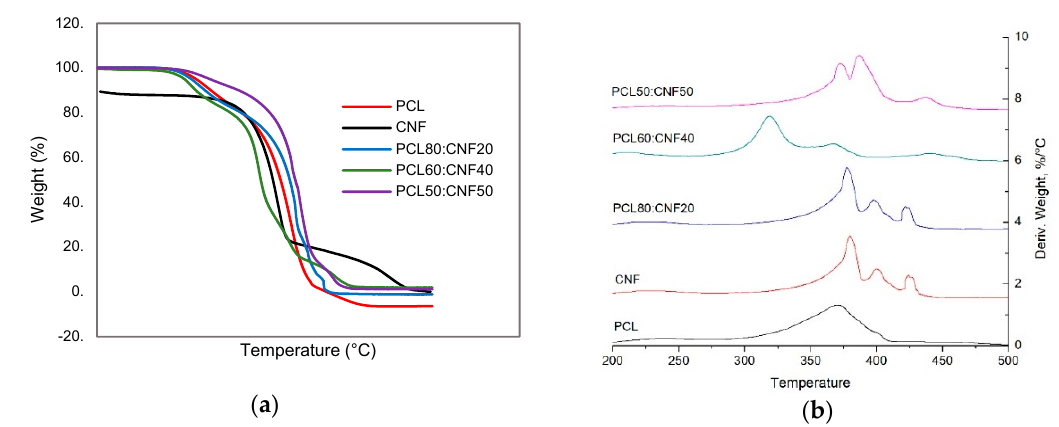
Figure 4. Thermogravimetric analysis: ( a ) TGA curves of cellulose nanofibers (CNF), polycaprolactone (PCL), and electro-spun membranes of 50:50, 60:40, and 80:20 PCL/CNF ( v / v ) ratios. ( b ) DTG curves of cellulose nanofibers (CNF), polycaprolactone (PCL), and electro-spun membranes of 50:50, 60:40, and 80:20 PCL/CNF ( v / v ) ratios.